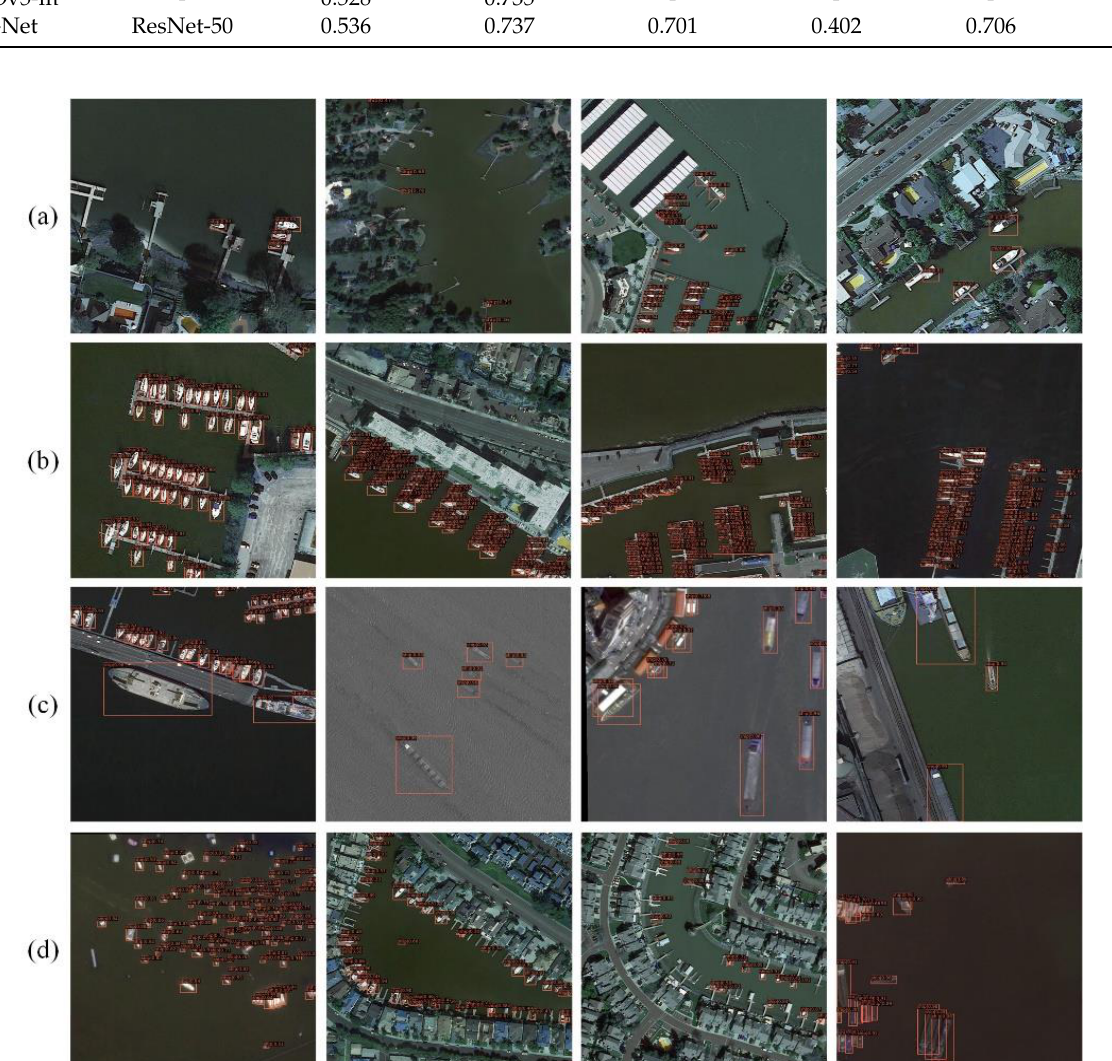
Figure 8. Some examples of the detection results on the DOTA v1.5 dataset in different situations. ( a ) Complex background; ( b ) dense distribution; ( c ) multiple scales; ( d ) different directions and aspect ratio.